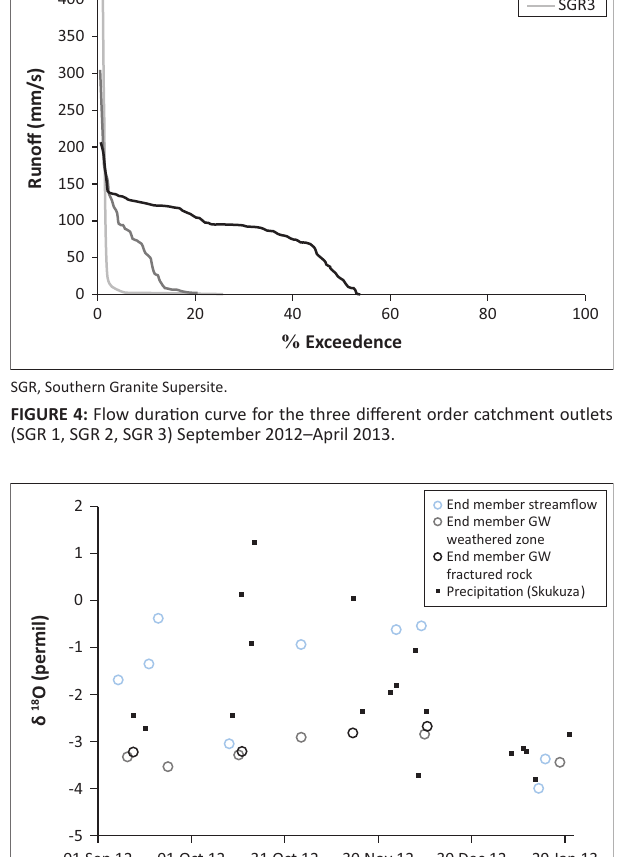
01 Sep FIGURE 5: Time series of d 18 O isotopes in groundwater and surface water during the study period.